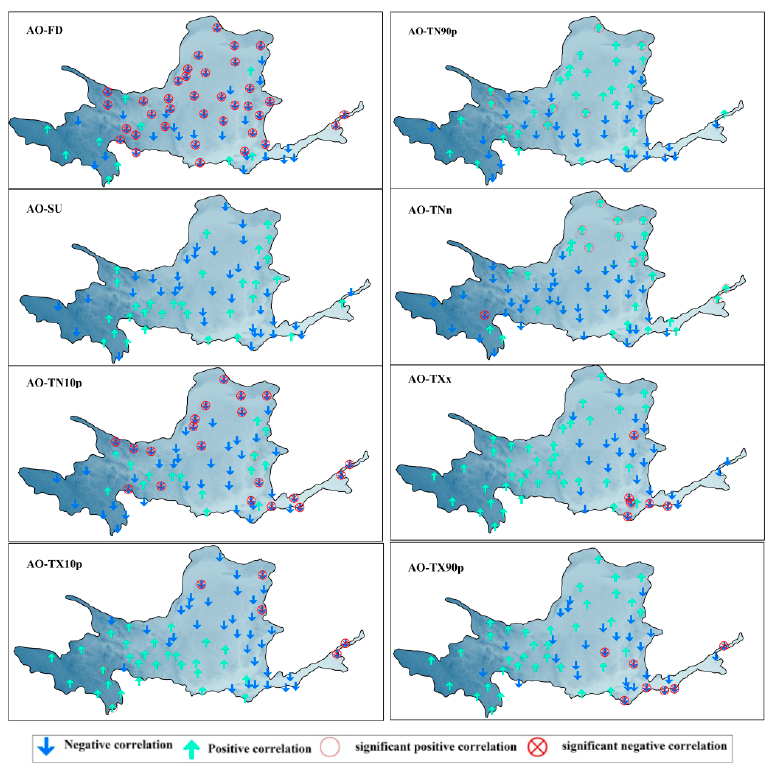
Figure 5. The potential connection between temperature extremes and the Arctic Oscillation (AO).